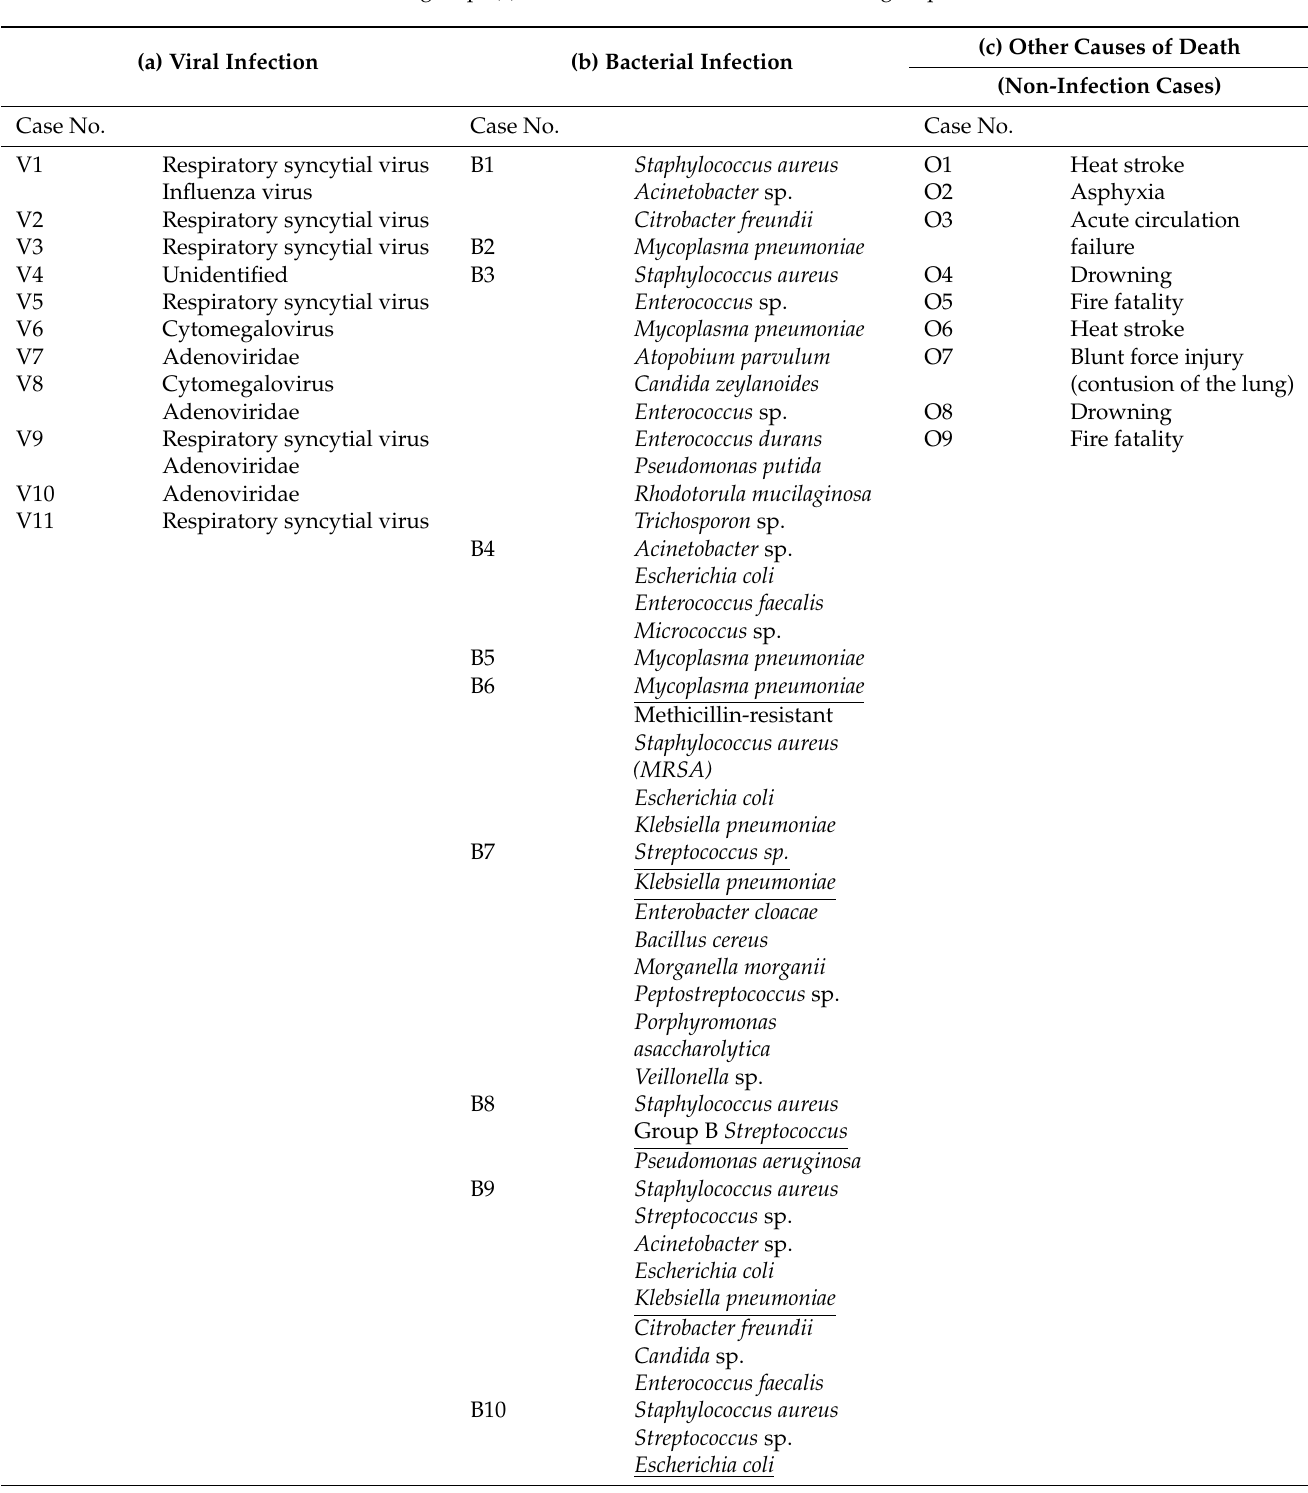
Table 7. Viral names and bacterial types detected in the (a) viral infection group and (b) bacterial infection group. (c) causes of death in the non-infection